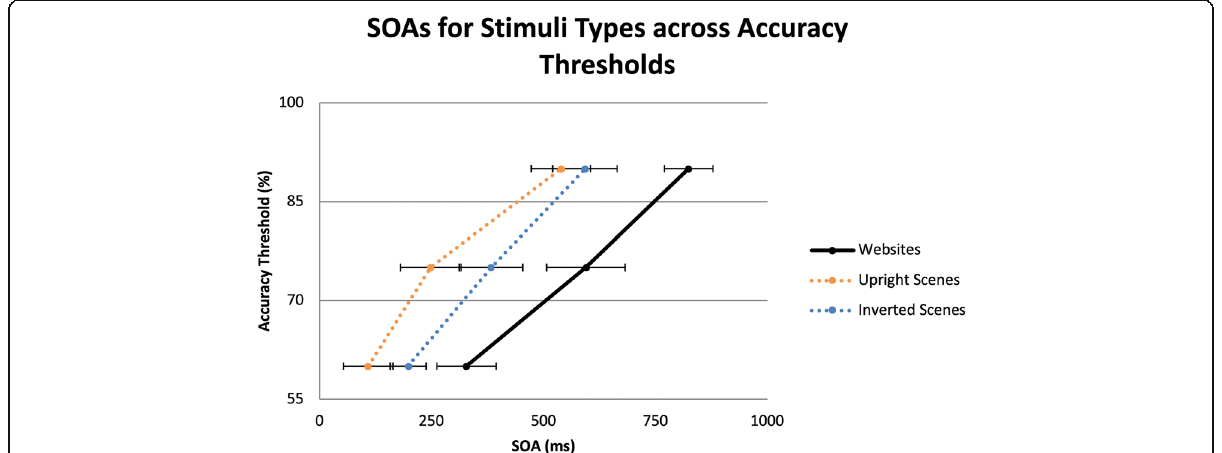
Fig. 5 Mean SOAs for scene categories across accuracy thresholds. Maximum stimulus durations were limited to 140 ms, with blank ISIs making up the rest of the time for each SOA. Error bars are within-subjects 95% confidence intervals (Cousineau, 2005; Morey,